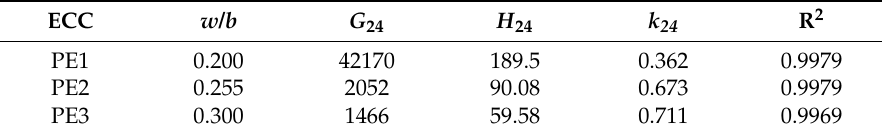
Table 12. Regression coefficients at f = 2.4 GHz and goodness of fits for Equation